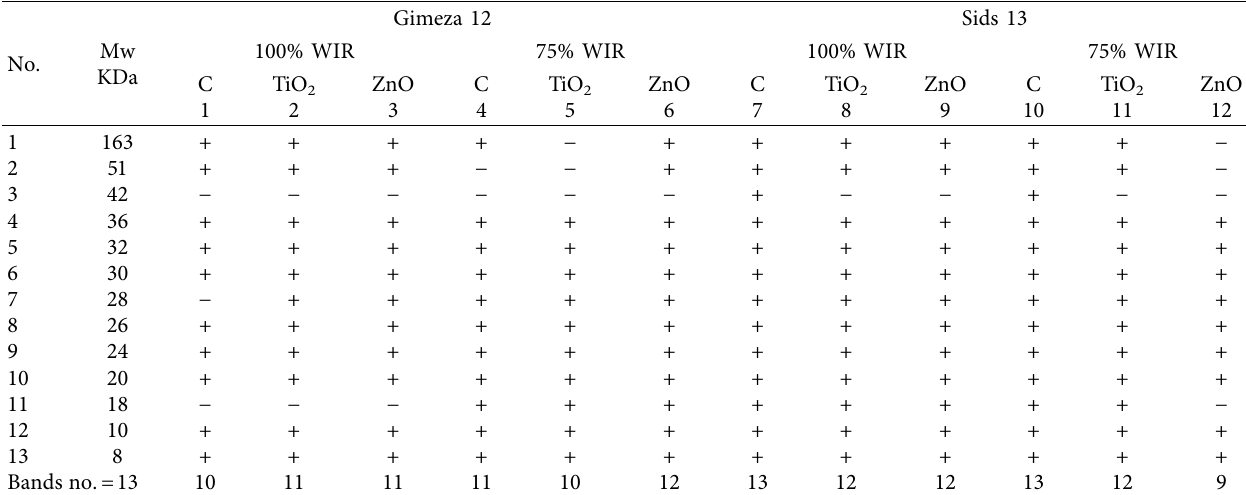
Table 2: The effect of nano-TiO 2 or nano-ZnO (10 mg/L) on protein banding patterns of SDS-PAGE of both wheat cultivars (Gimeza 12 and Sids 13) subjected to different levels of water irrigation requirement at 75 days from sowing (+: present and − : absent).